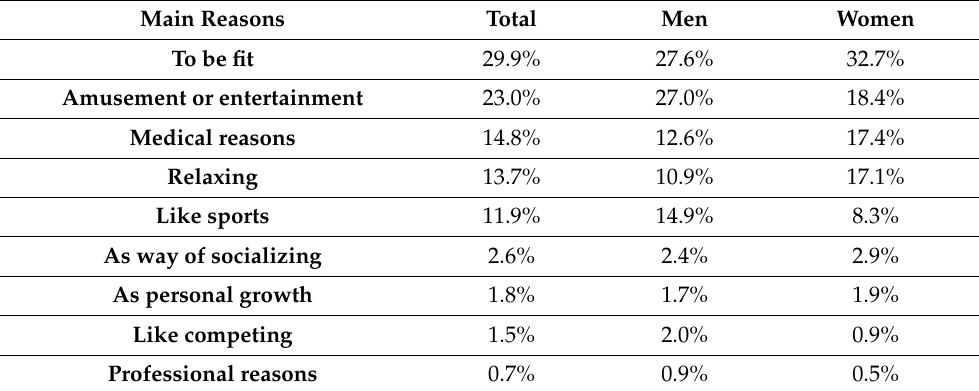
Table 2. Main reasons why people practiced sports in 2015, as a percentage of the population that practiced sports in the last year for each group.